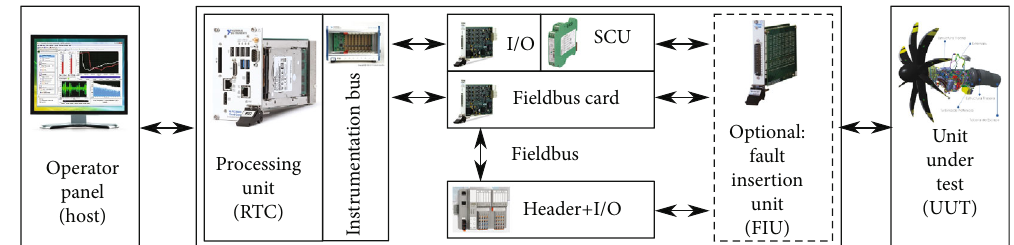
Figure 15: Veri fi cation equipment with